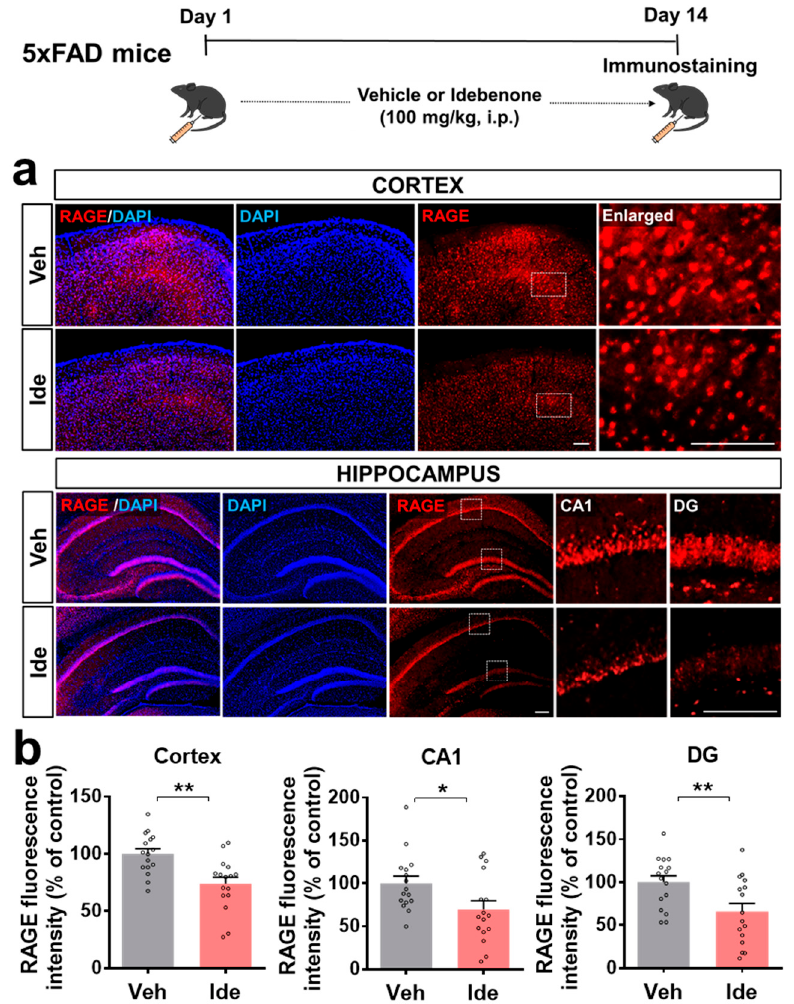
Figure 2. Idebenone significantly reduces RAGE expression in 5xFAD mice. ( a ) Representative images of cortical and hippocampal RAGE immunofluorescent staining. Idebenone or vehicle was administered daily to 3-month-old mice for 14 consecutive days as shown at the top of the figure. Immunostaining of brain sections with anti-RAGE was then performed. ( b ) Quantification of the results (n = 16 brain slices from four mice/group). * p < 0.05 and ** p < 0.01 vs. vehicle-treated control. Scale bar = 100 µm for cortex and 200 µm for hippocampus.